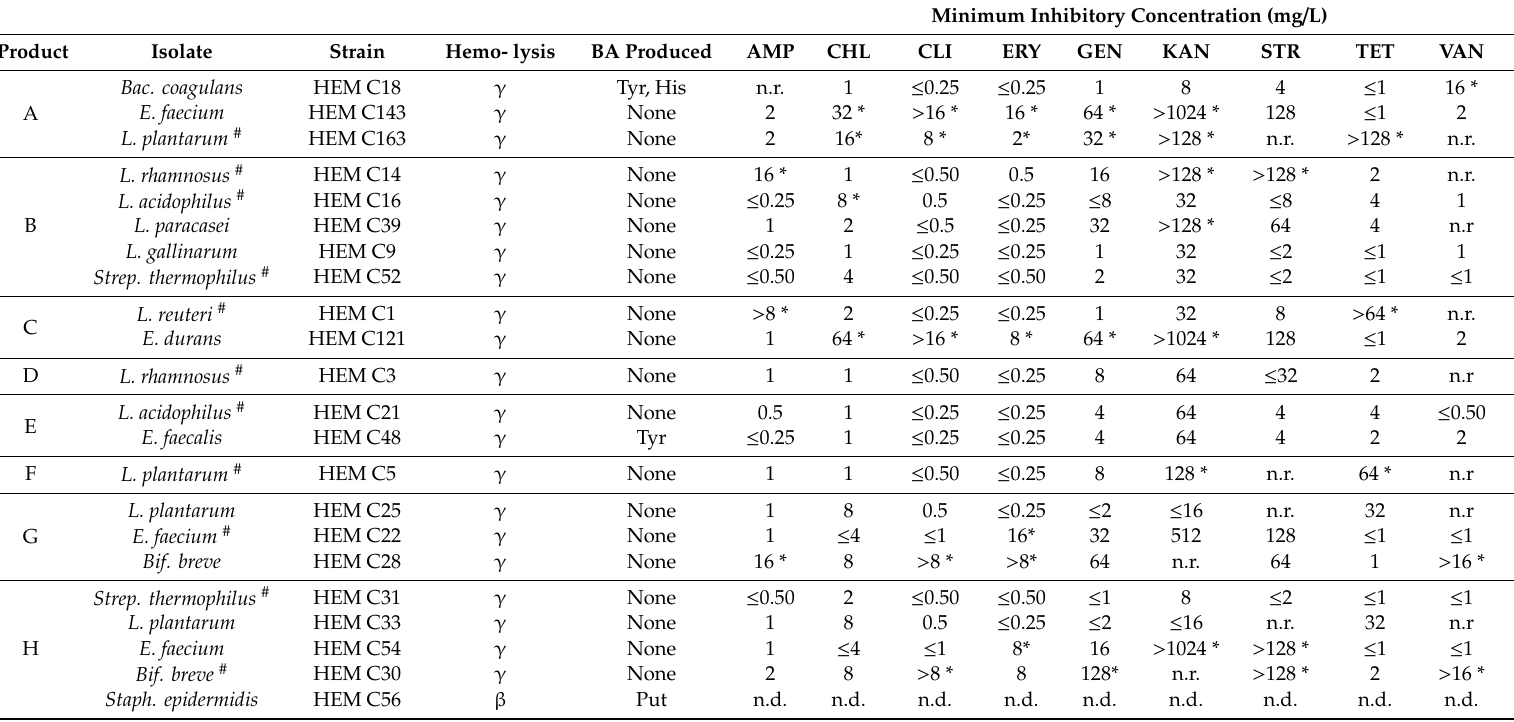
Table 3. Hemolysis, biogenic amine production, antibiotic resistance and minimum inhibitory concentrations of the isolated bacterial species in commercial probiotic products for children. Strains have been deposited in the internal collection under the numbers shown in the